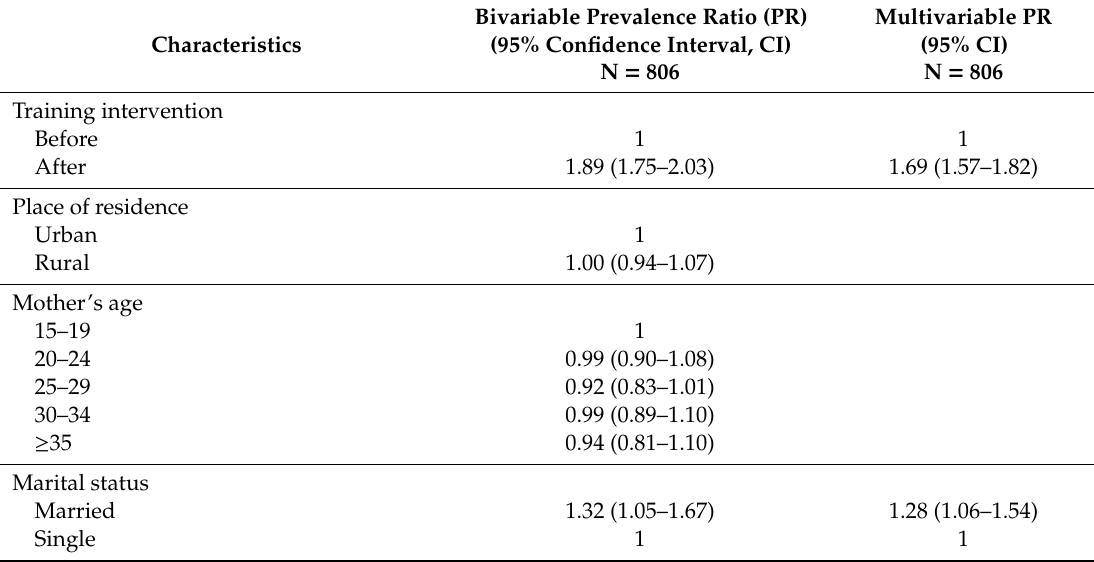
Table 3. Bivariable and multivariable analysis among mother–infant pairs before and after the BFHI training in Juba Teaching Hospital in South